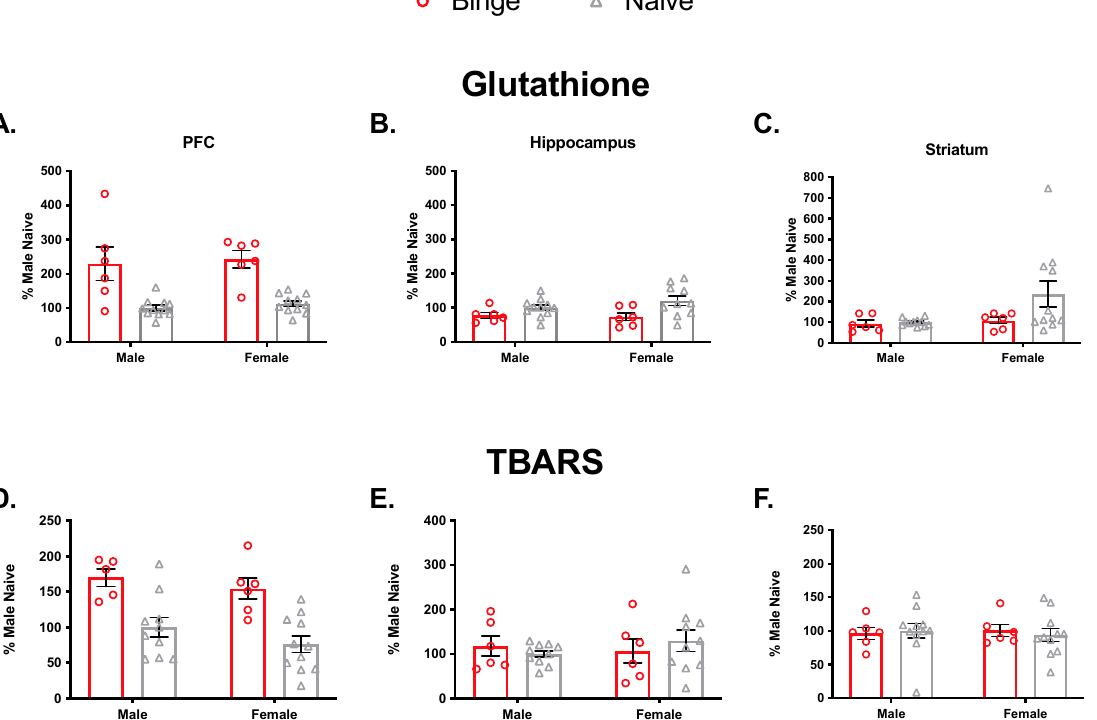
Figure 2. Effects of acute binge on glutathione levels and lipid peroxidation. A single binge significantly elevated GSH level in PFC ( A ), reduced it in hippocampus ( B ), and did not change levels in the striatum ( C ). Bars represent ± SEM from 6–11 subjects per group. Significant lipid peroxidation was detectable in both male and female PFC compared to naïve subjects ( D ). There was no detectable lipid peroxidation damage from a single binge treatment in hippocampus ( E ) or striatum ( F ).